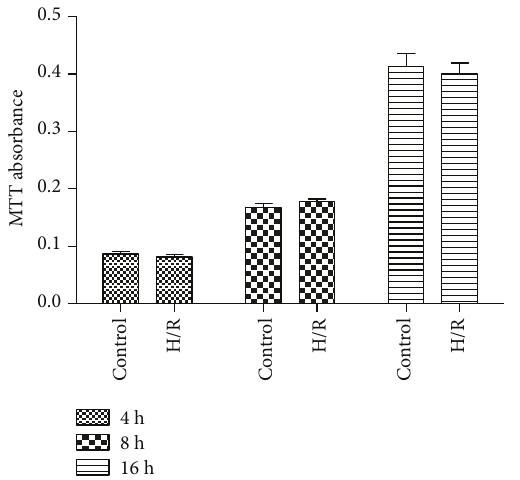
Figure 1: Cell viability of BMSCs after H/R treatment.